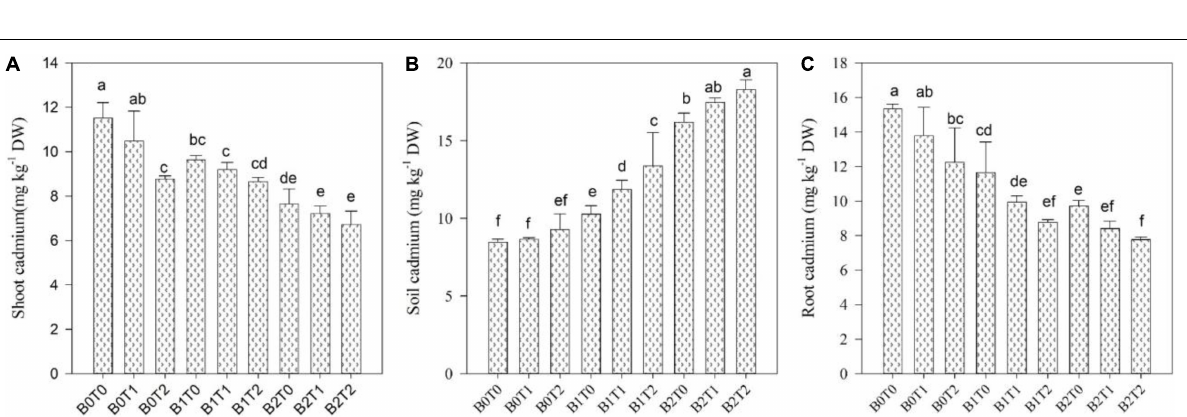
Frontiers in Plant Science |